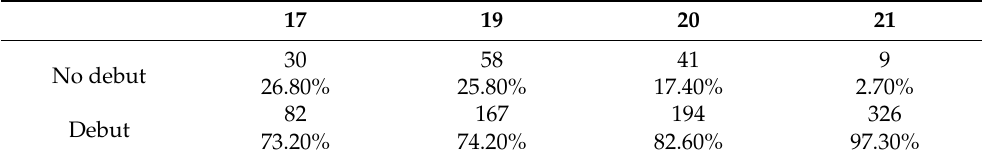
Table 2. Descriptive statistics of players ’ development according to age.